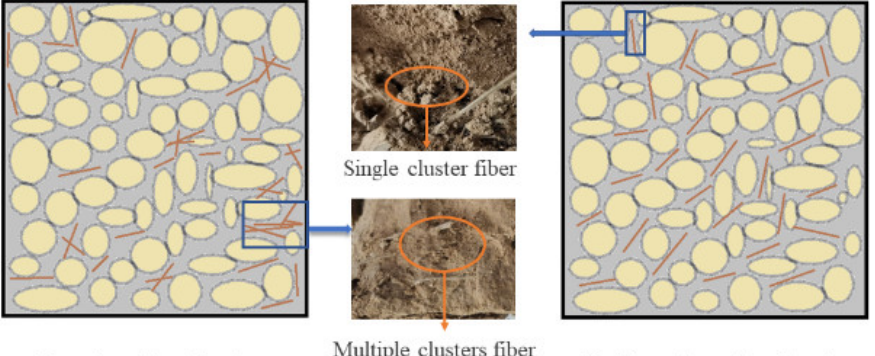
Figure 10. Dense and uniform fiber distributions in the matrices.